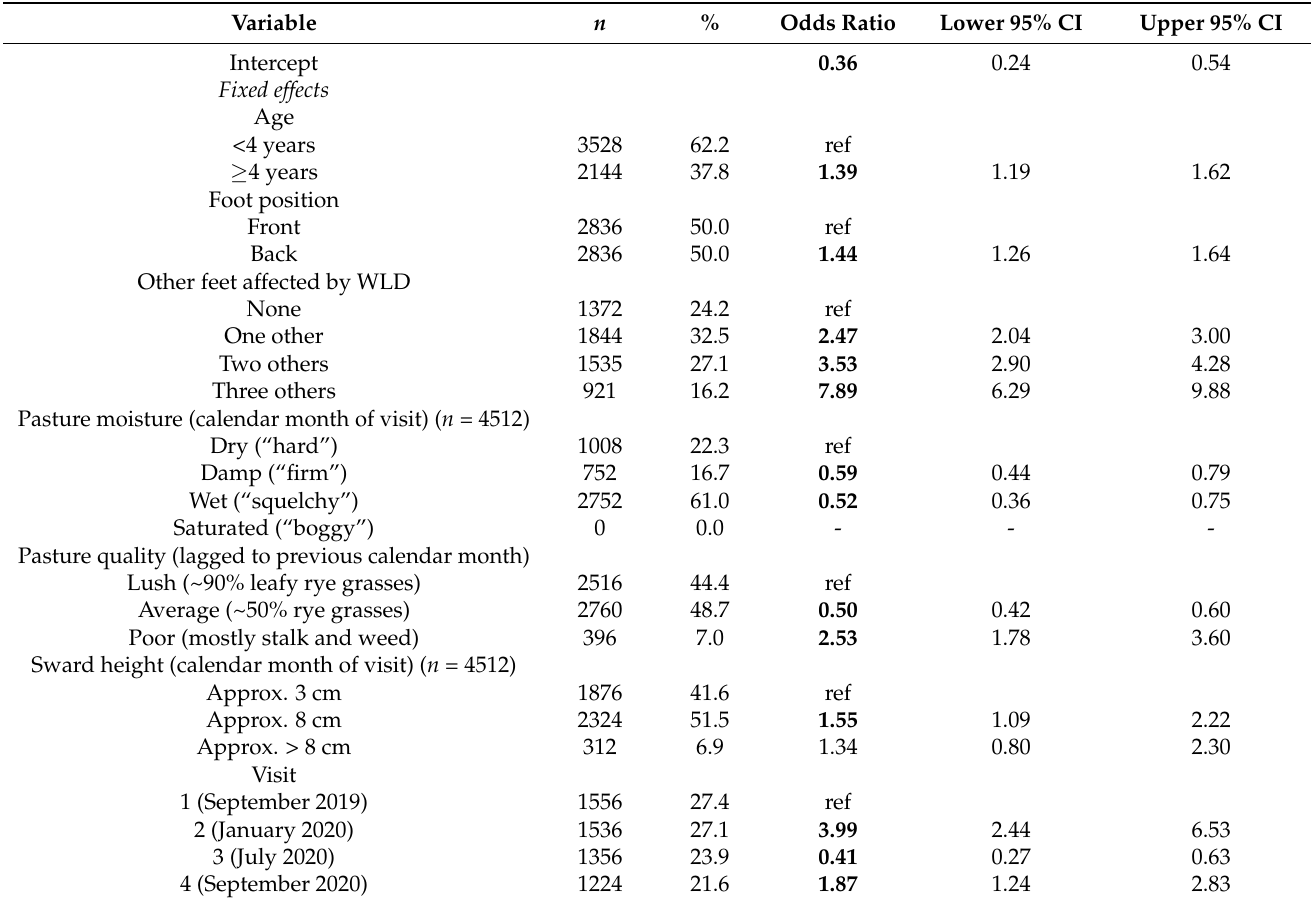
Table 9. Final multivariable model of the associations with the presence of WLD for 5672 foot-level observations of 400 ewes.